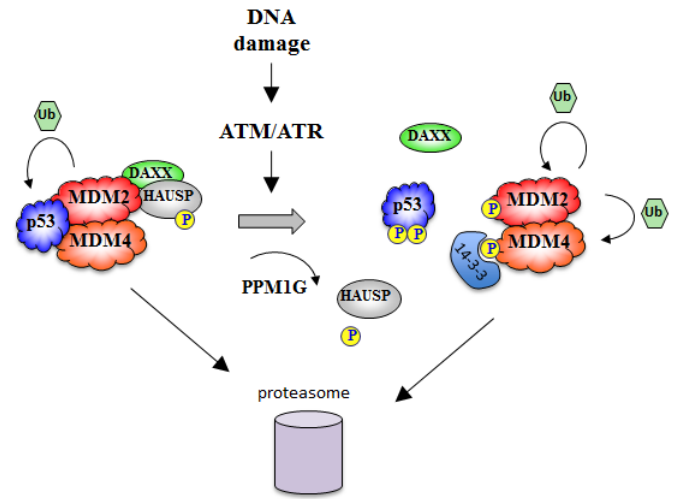
Figure 3. Mechanism of p53 activation in response to DNA damage. p53 is shown together with its main regulators as a complex before activation (left) and following DNA damage-induced phosphorylation and dissociation (right). The mechanism is detailed in the